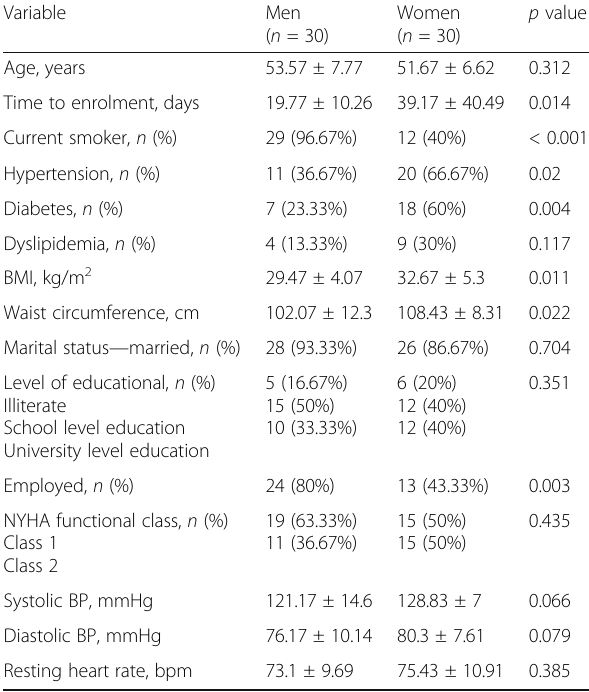
Table 1 Baseline clinical findings and measurements